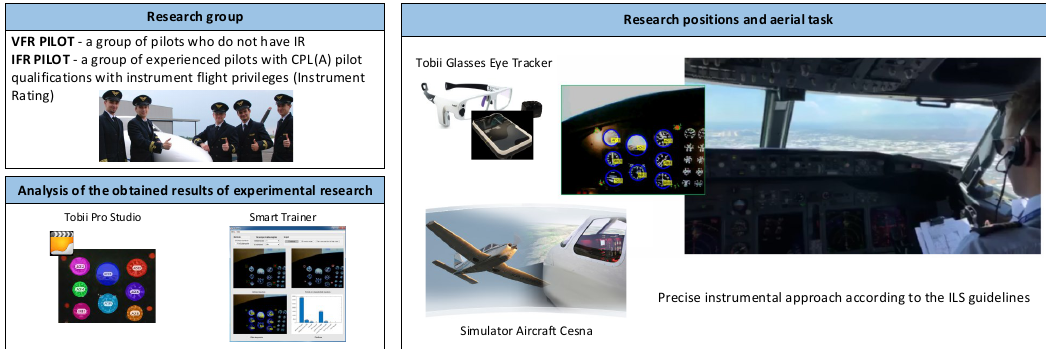
Figure 2. Experiment procedure scheme.